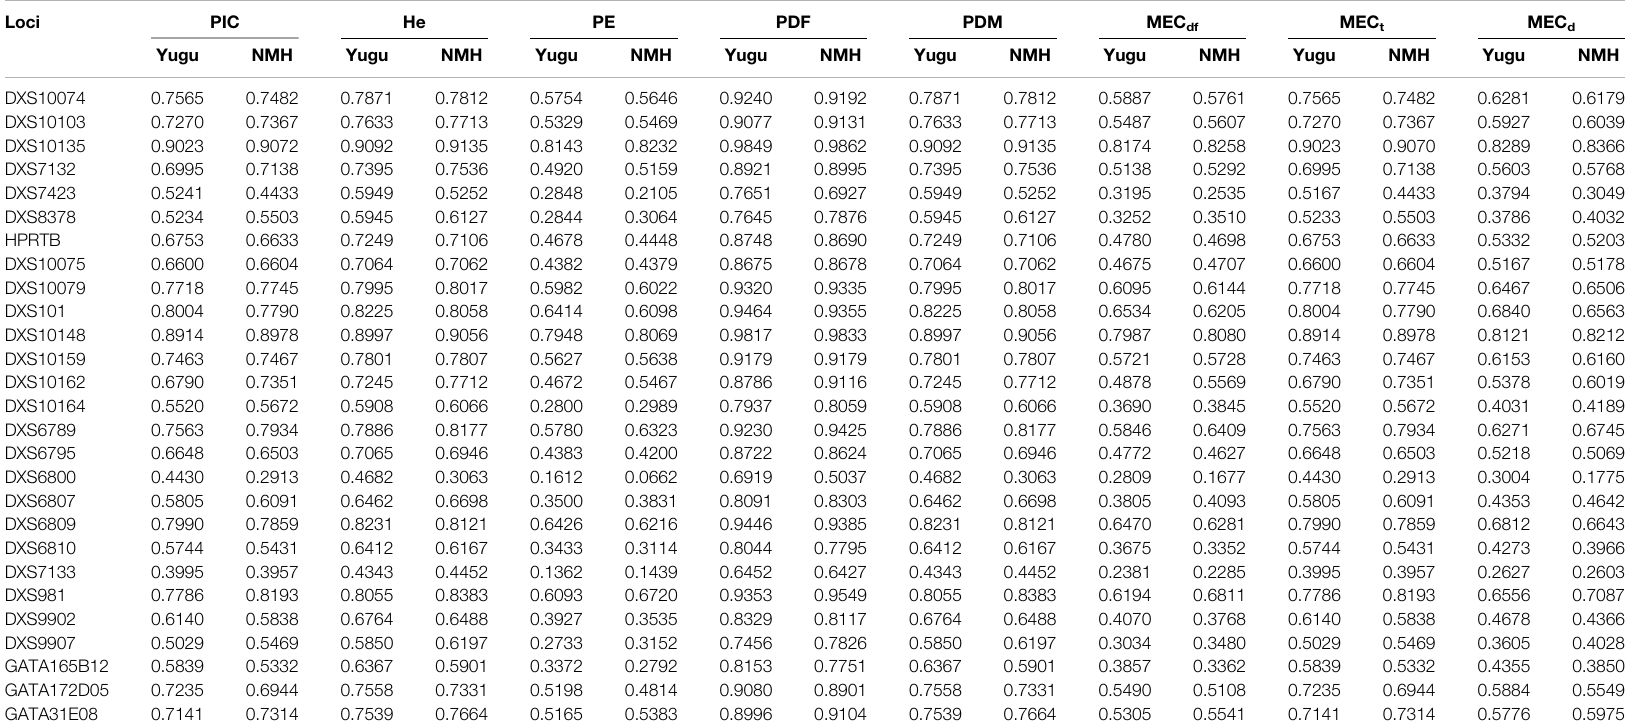
TABLE 1 | Forensic ef fi ciency parameters of the 27 X-STR loci in the Yugu group and NMH population (N Yugu = 165; N NMH = 333).